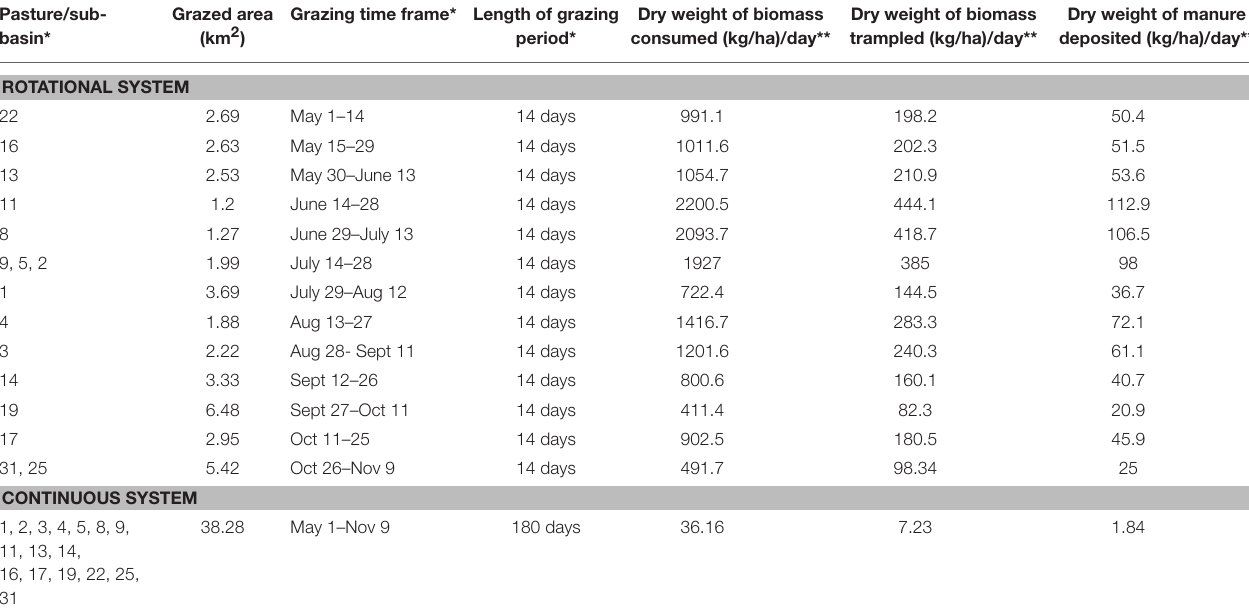
TABLE 2 | Input information for SWAT grazing scenario setup where * denotes information sources from discussions with Ucross management and ** denotes information sourced from Almendinger and Murphy (2005) for grazing inputs in SWAT. Pasture/sub-